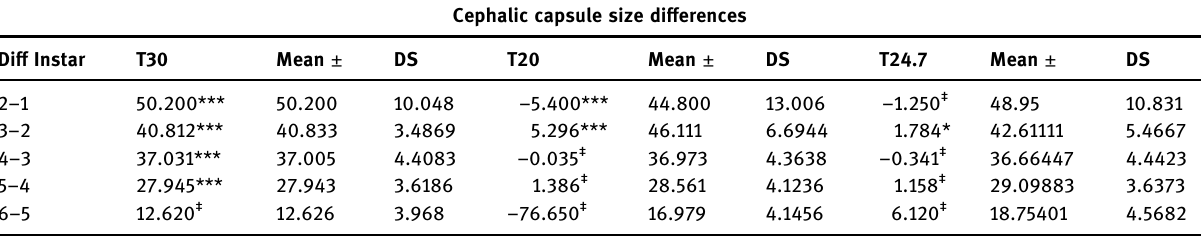
Table 3: Di ff erences between the size ( mm ) of the cephalic capsule of D. busckella at three di ff erent temperatures 30, 20, and 24.7°C ( T30, T20, and T24.7 ) under controlled